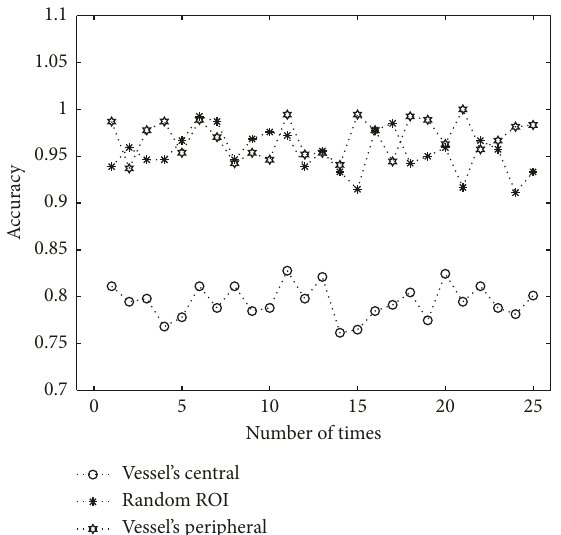
Figure 9: Identification accuracy of BP network for 25 training times (i.e., 25 networks).